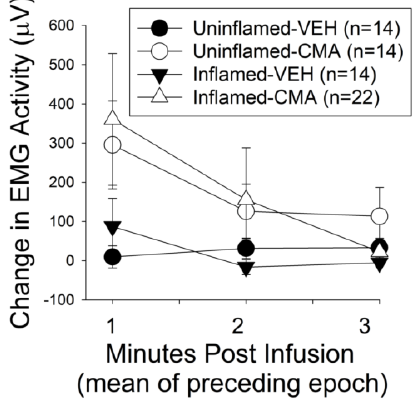
Figure 1. Response to intravesical infusion. Change in rectified EMG activity of superior oblique musculature when compared to baseline measures prior to drug infusion in rats with and without inflamed bladders. VEH indicates intravesical infusion of vehicle (mineral oil) whereas CMA indicates intravesical infusion of 10% cinnamaldehyde. There was a significant effect of CMA treatment but the presence/absence of zymosan-induced bladder inflammation did not have any statistically significant effect.